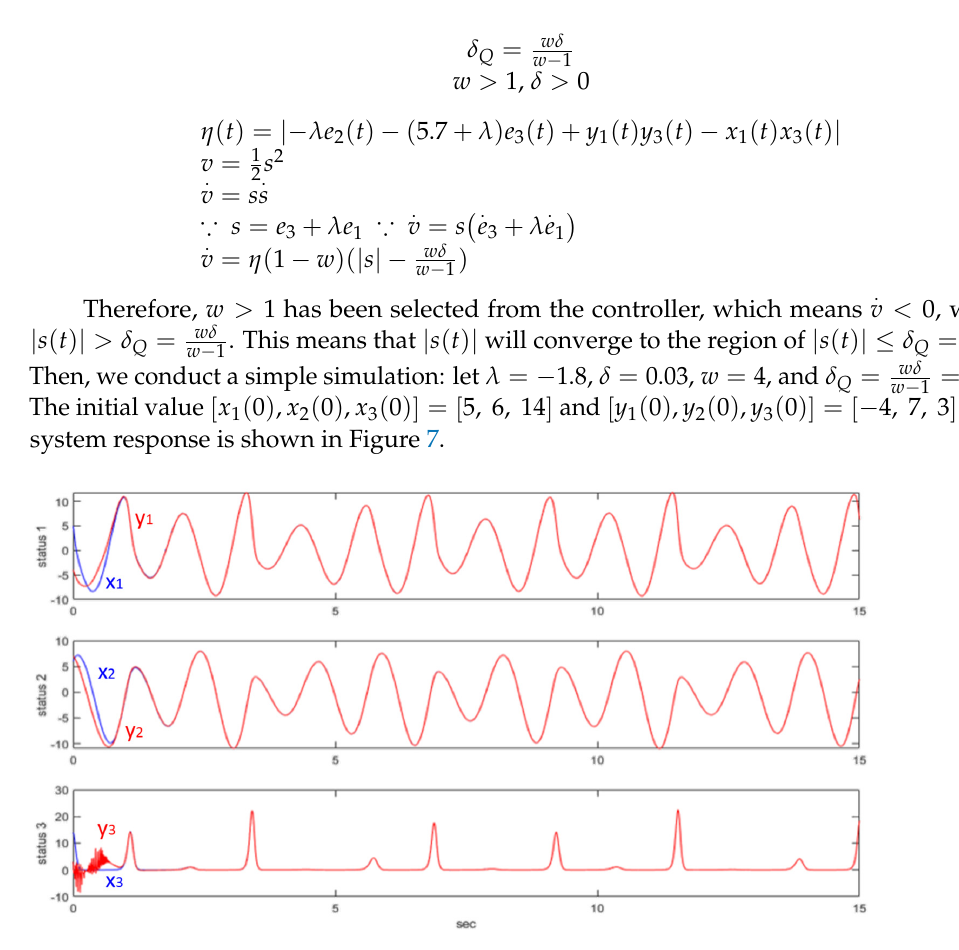
Figure 7. QSM controller synchronizing the Rössler chaotic system.